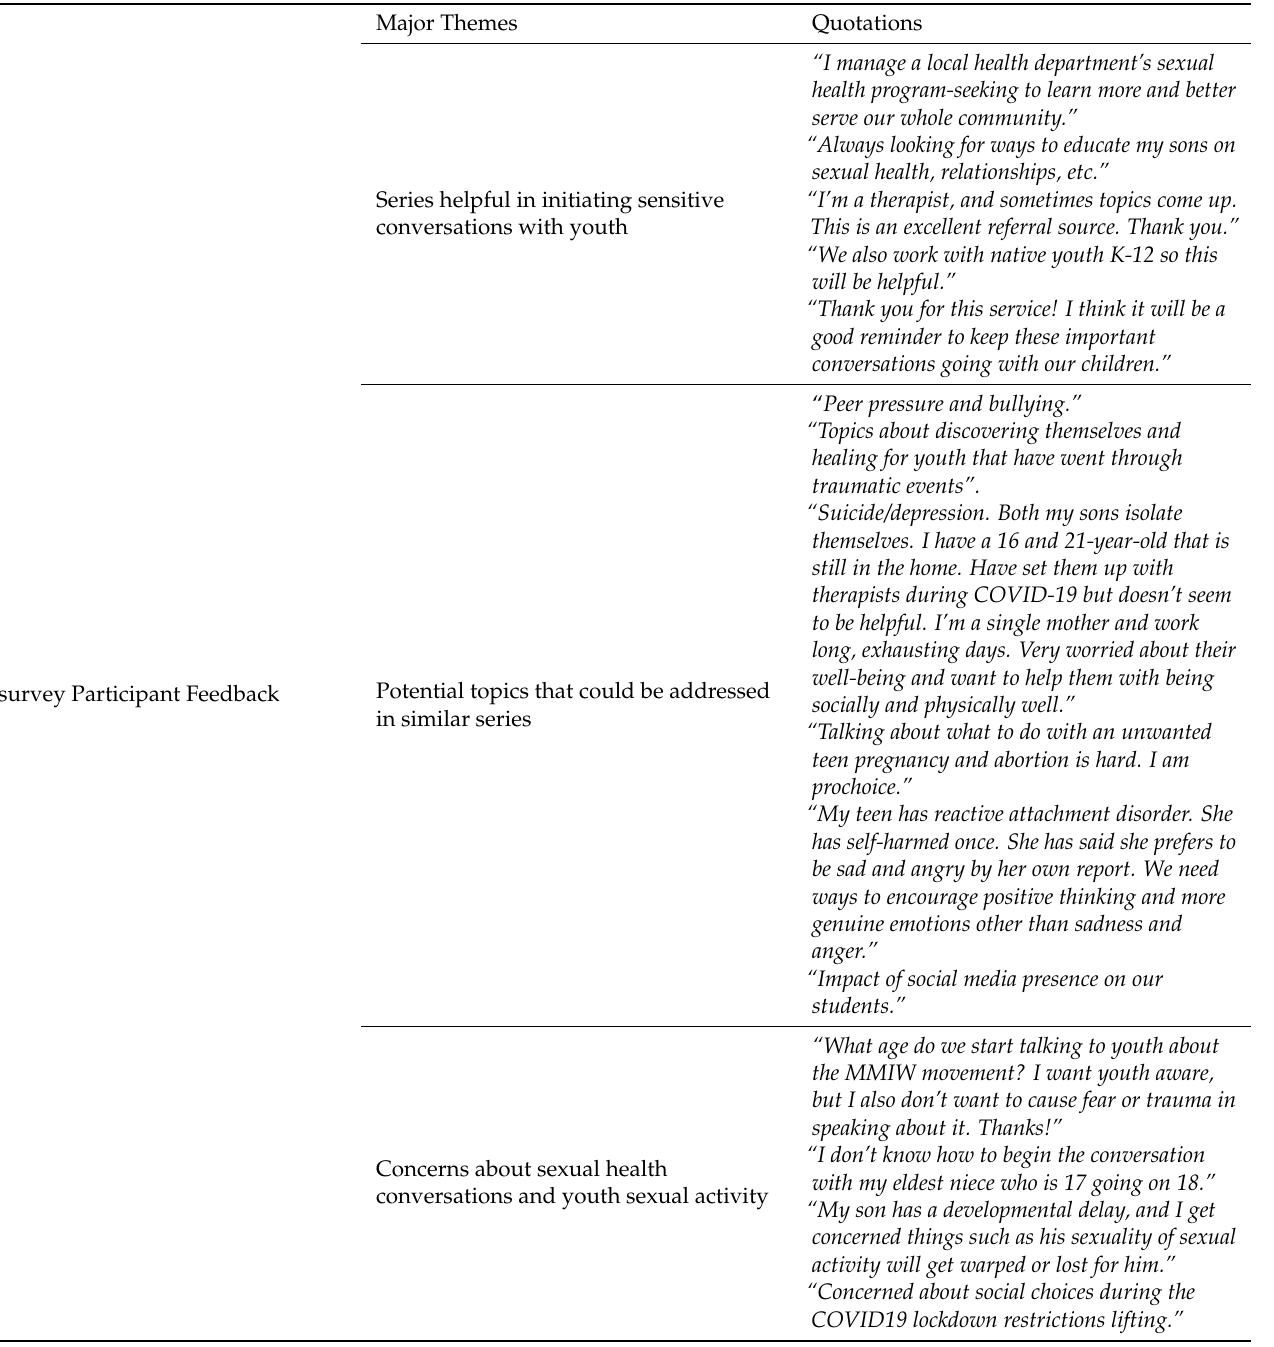
Table 4. Pre-survey Participant Feedback Qualitative Themes and